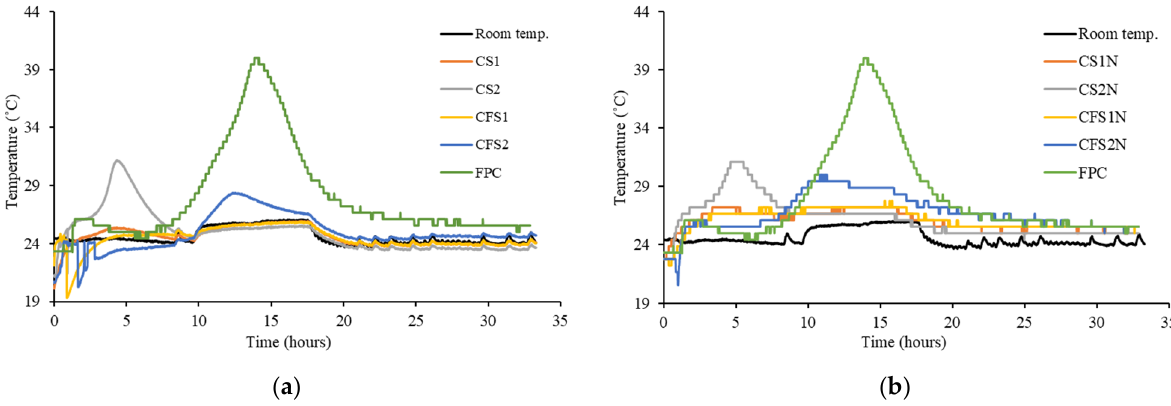
Figure 7. Evolution of temperature with time for binders: ( a ) FA (55% to 60%) + GGBFS (40% to 45%), ( b ) 50% FA + 50% GGBFS.